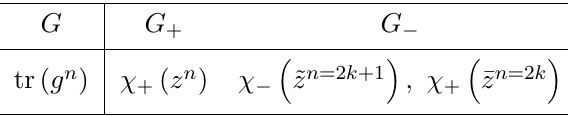
Table 6 . Traces of odd and even powers of group elements g ∈ G = { G + , G − } on the even branch G + and the odd branch G − . Here we have adopted an abbreviated notation z n ≡ ( z n similarly for ˜ z n and ¯ z n . The group G here could be either the group O (4) or the charge